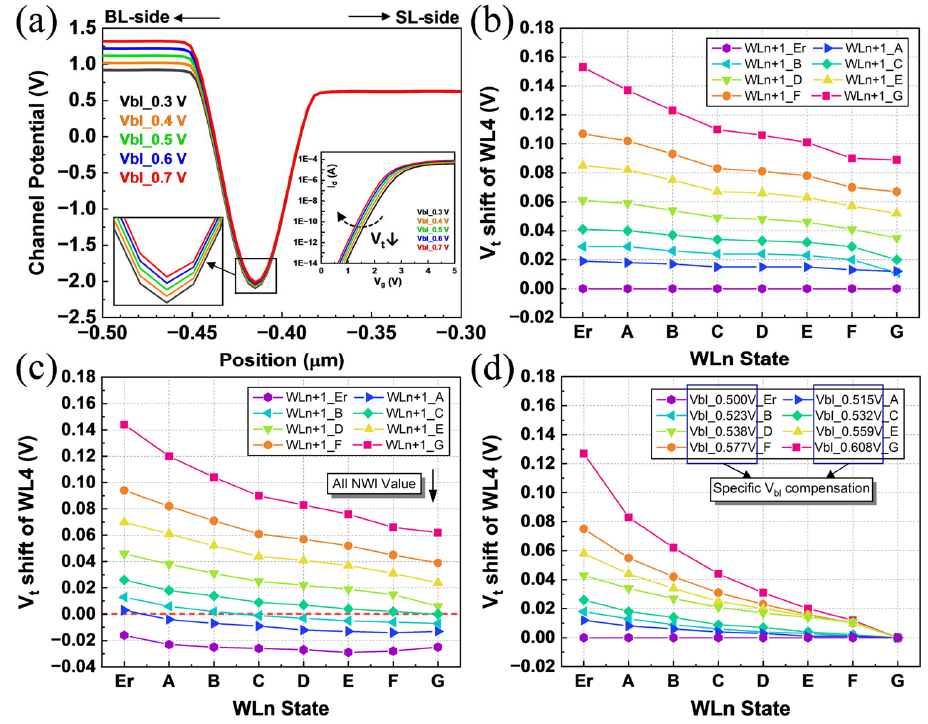
Figure 7. ( a ) The channel potential barrier and I d - V g curve of the victim cell when reading with different V bl applied on BL. ( b ) The NWI curves for all combinations of WLn and WLn+1 states. One curve represents the NWI of WLn states affected by a certain WLn+1 state. ( c ) The all-state NWI curves downward as V bl increases from 0.50 V to 0.53 V. ( d ) The all-state NWI curves are optimized with adaptive V bl compensation by mitigating the interference from